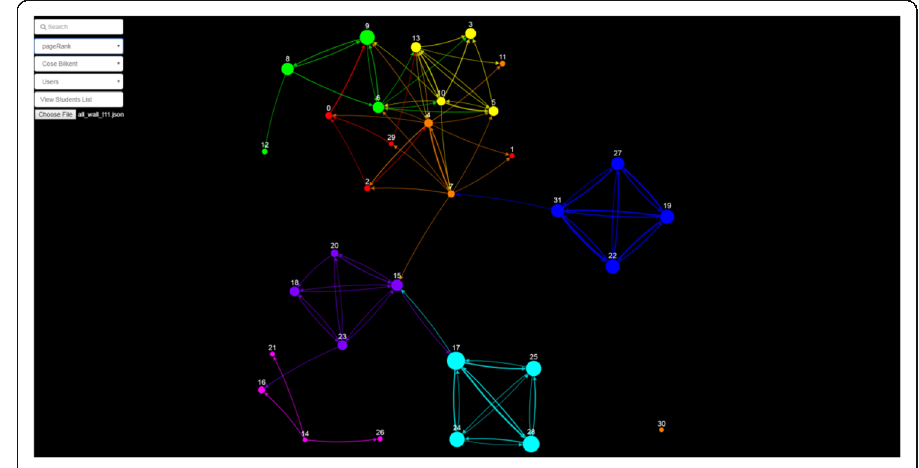
Fig. 9 Students ’ collaboration status in weeks 11 and 12 of the semester. The visualization is provided by StudentViz using Cose-Bilkent layout. Nodes represent students and their diameters are proportional to PageRank metric. Through this image, just as in case of Fig. 8, the instructor can visualize the collaboration status for a specific timeframe, thus being able to observe the evolution of learners ’ collaboration. This figure supports VN1 and VN2, as well P1, P2 and